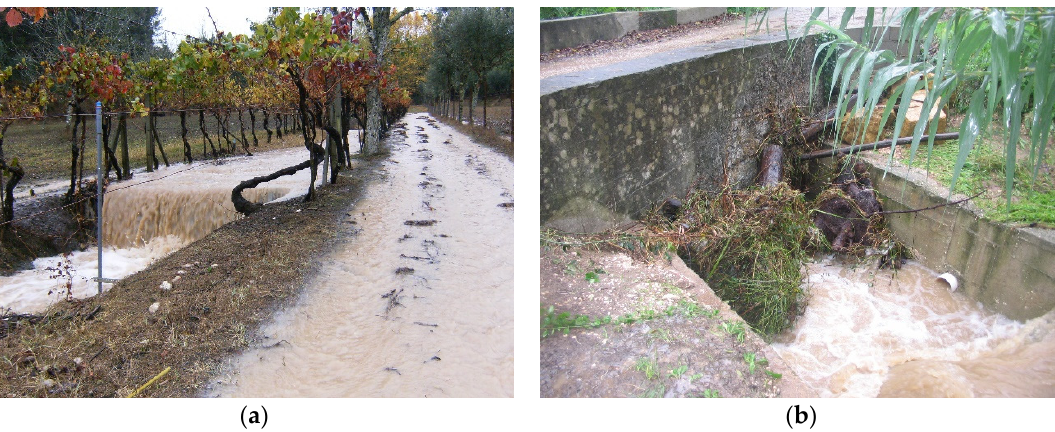
Figure 4: Causes of erroneous measurements of high peak discharge during major storm events, leading to lower observations at upstream gauging stations than in real conditions. ( a ) Stream overflow due to constructed channel section constriction in Quinta sub-catchment, to allow people and animals to cross the stream; and ( b ) partial blockade of hydraulic infrastructure in Covões sub-catchment with sediment and litter carried during high-intensity storms.